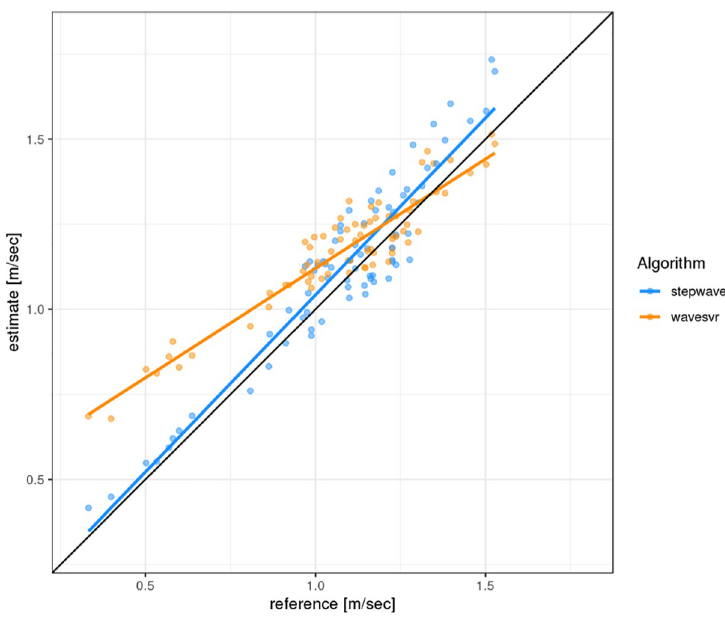
Fig 3. Scatter plot of mean speeds for each section of the parcours. Displayed are the speed estimates of the two algorithm combinations with identical step detection plotted against the corresponding reference measures. The algorithms use the accelerometry signal from the belt mounted actibelt 1